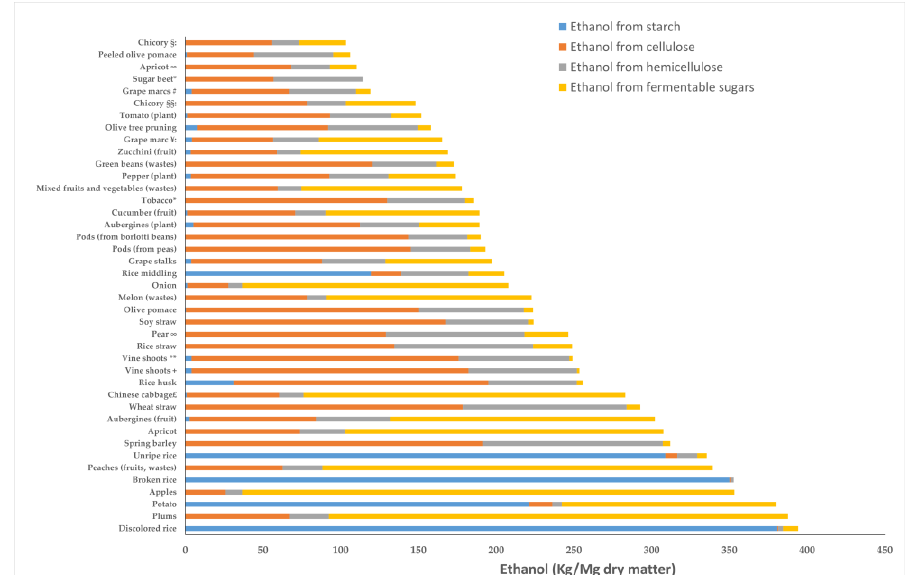
Figure 2. Potential ethanol yield (kg) per Mg of dry residue from starch, cellulose, hemicellulose, and fermentable sugars.